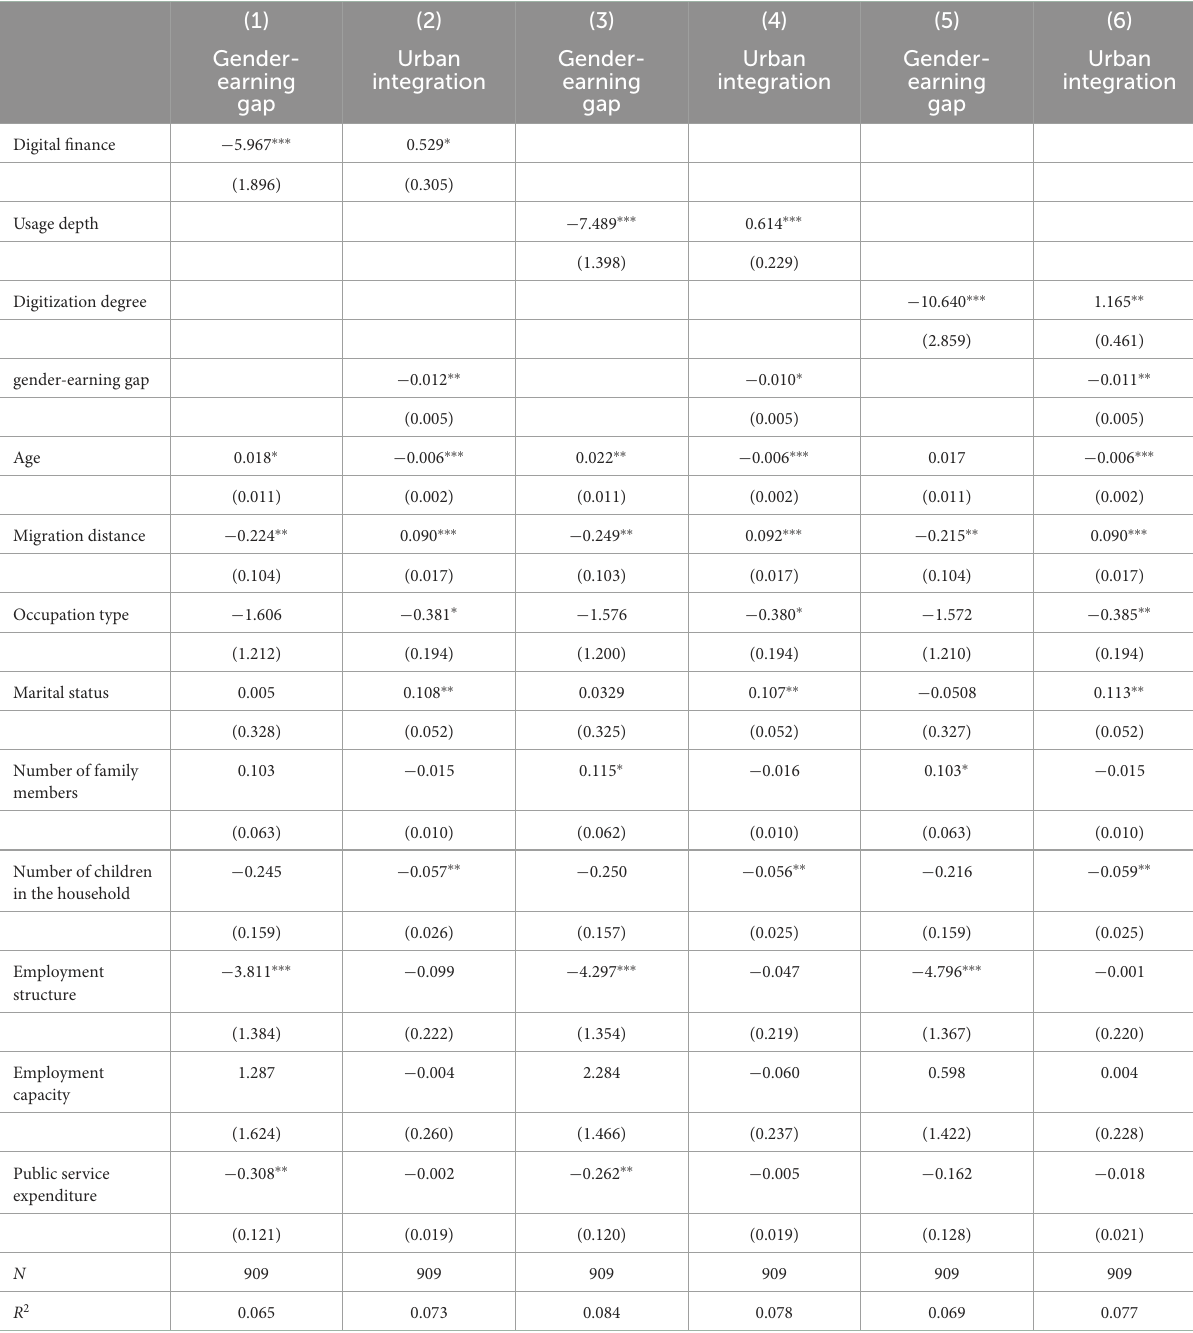
TABLE 9 Results of the effect of digital finance on migrant workers’ urban integration (mediation effect of their gender-earning gap).